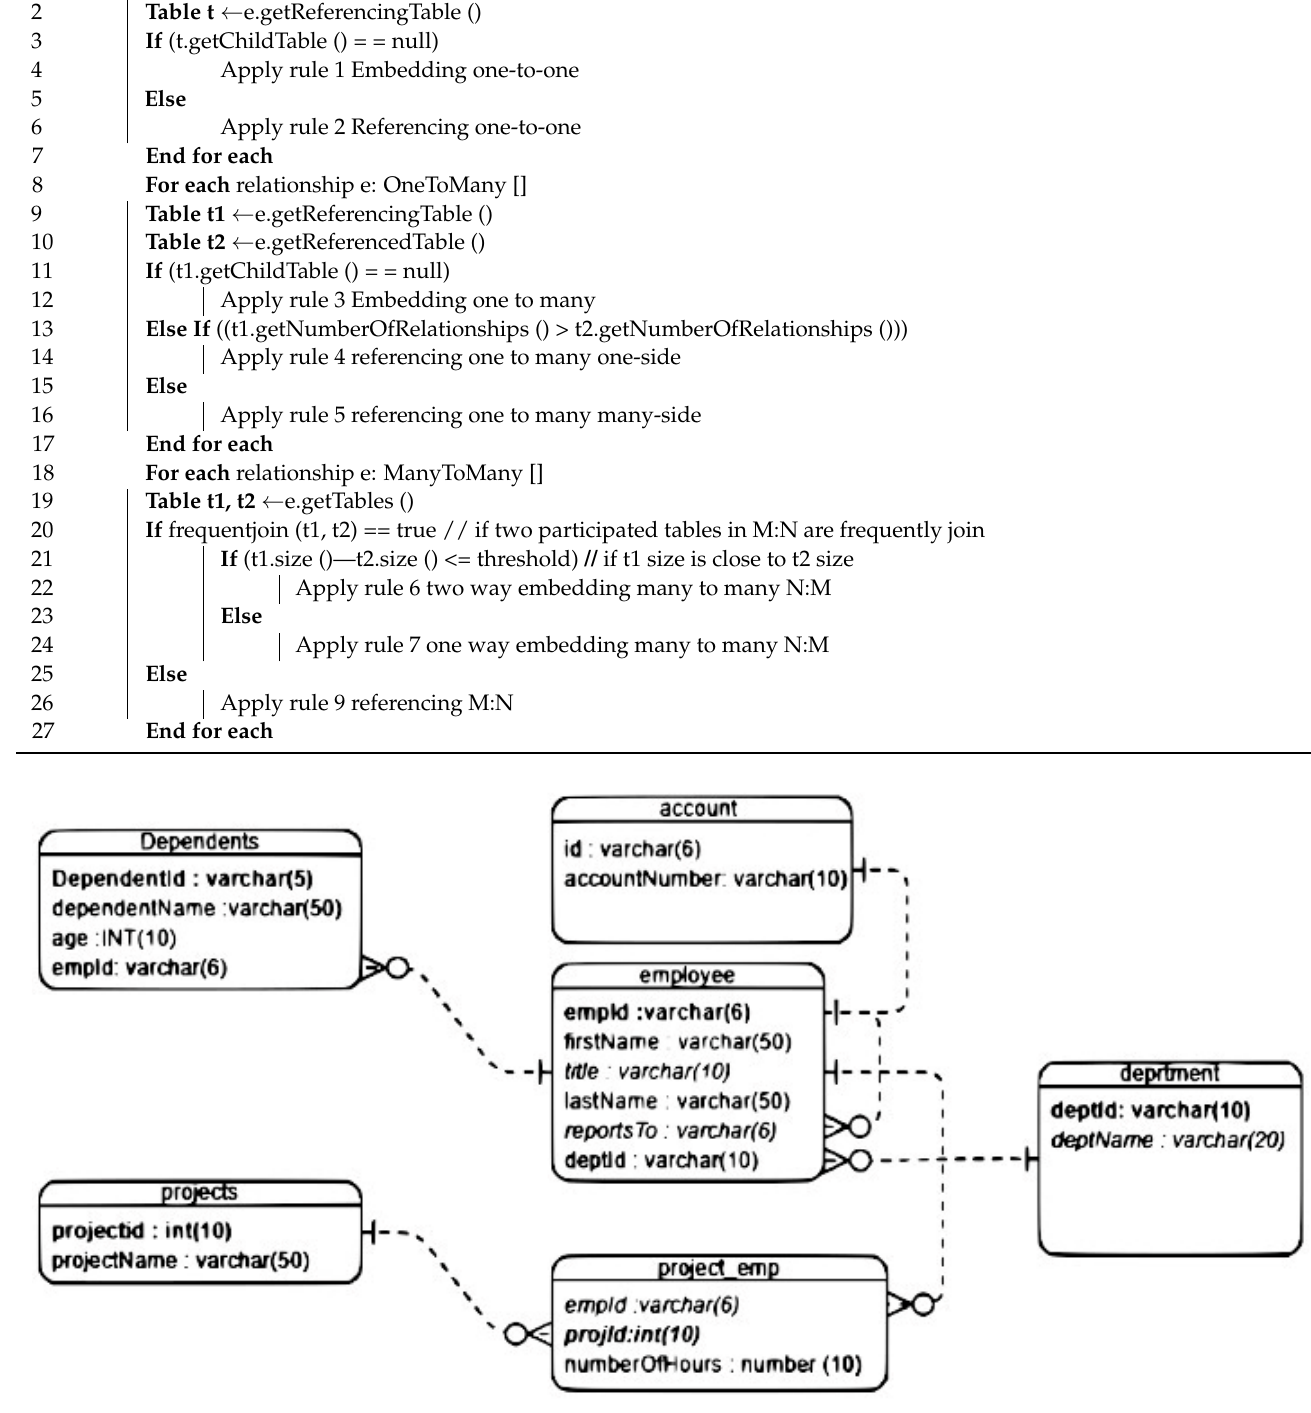
Figure 2. Simple RDB example.